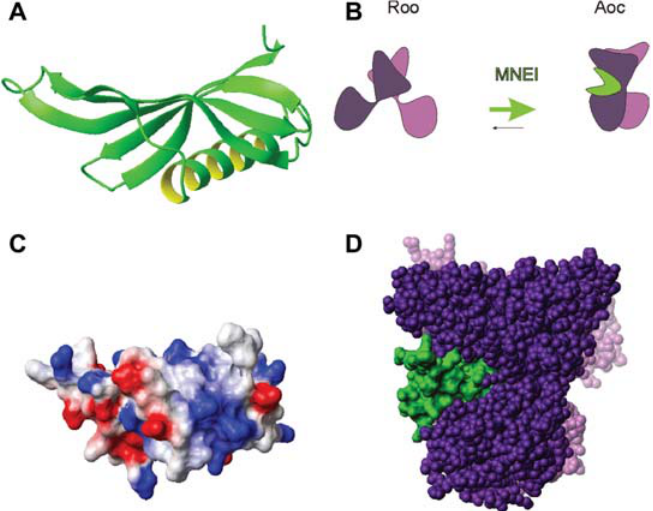
Figure 1 The structure of MNEI and its complex with the sweet receptor. (A) Ribbon representation of the NMR structure of MNEI, seen from the side that interacts with the sweet receptor (14). (B) Sketch illustrating how a sweet protein can shift the equilibrium between the resting, open-open, form (Roo) and the active, open-closed, form (Aoc) of the sweet receptor. (C) Electrostatic surface of MNEI, with the same orientation as in panel (A). (D) Complex of MNEI and T1R2- T1R3, generated by in silico docking. The two protomers of T1R2-T1R3 are shown in an all atom representation. T1R2 atoms are colored in pink, T1R3 atoms in violet. MNEI is shown as contact surface in green. The models were generated by MOLMOL (15).